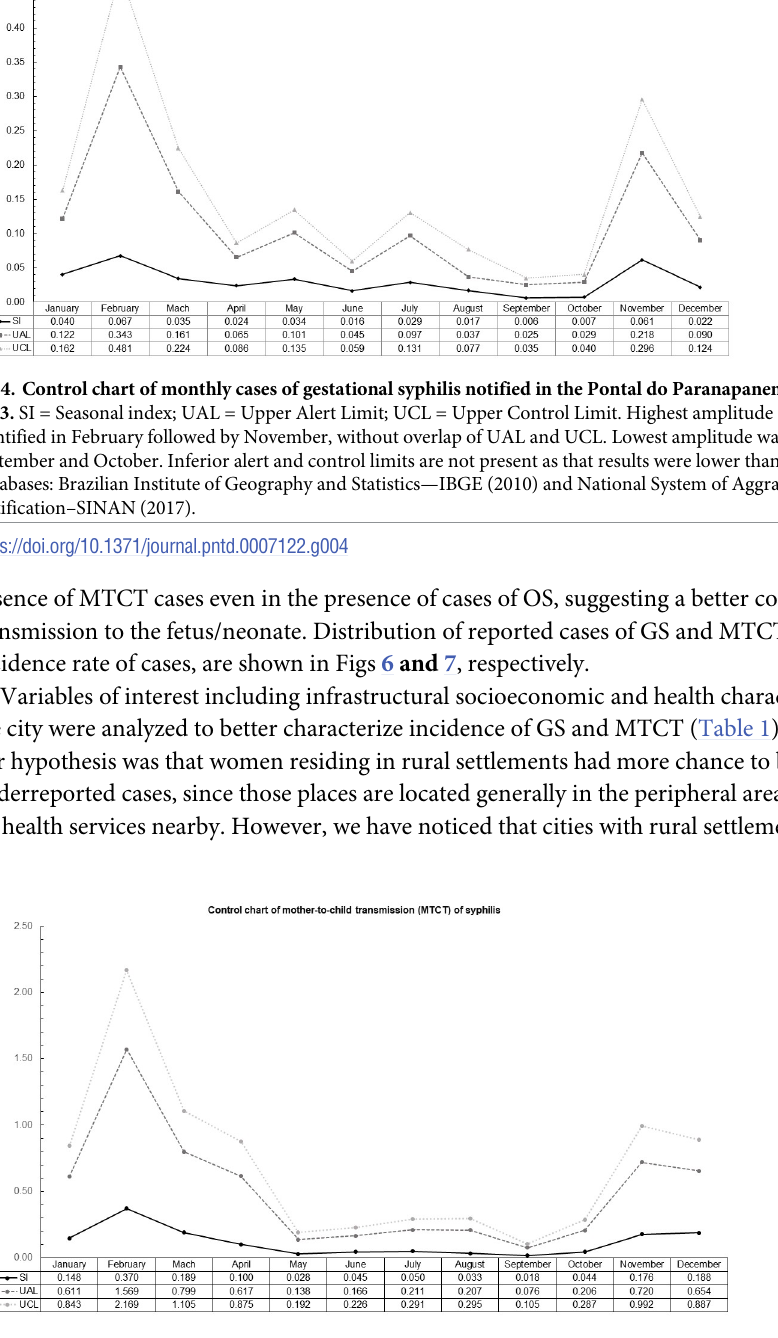
Fig 5. Control chart of monthly cases of MTCT of syphilis notified in the Pontal do Paranapanema from 2008 to 2013. SI = Seasonal index; UAL = Upper Alert Limit; UCL = Upper Control Limit. Highest amplitude of cases was identified in February followed by November, without overlap of UAL and UCL. Lowest amplitude was noticed in September. Inferior alert and control limits are not present as that results were lower than zero. Databases: Brazilian Institute of Geography and Statistics—IBGE (2010) and National System of Aggravations and Notification–SINAN